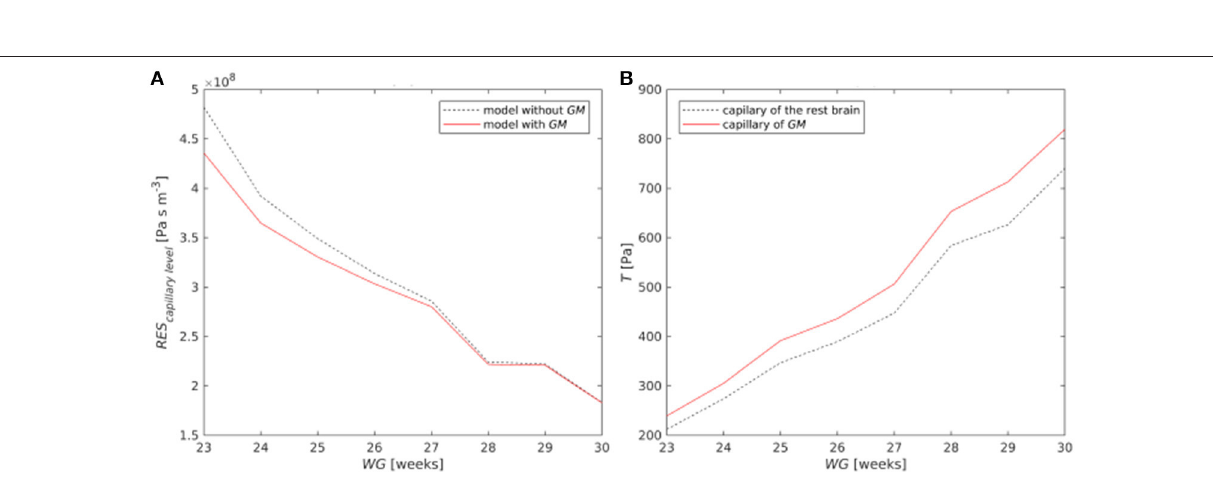
FIGURE 4 | (A) Resistance of the capillary layer with and without GM ; (B) Wall tension in a single capillary of the GM and in another area of the brain.